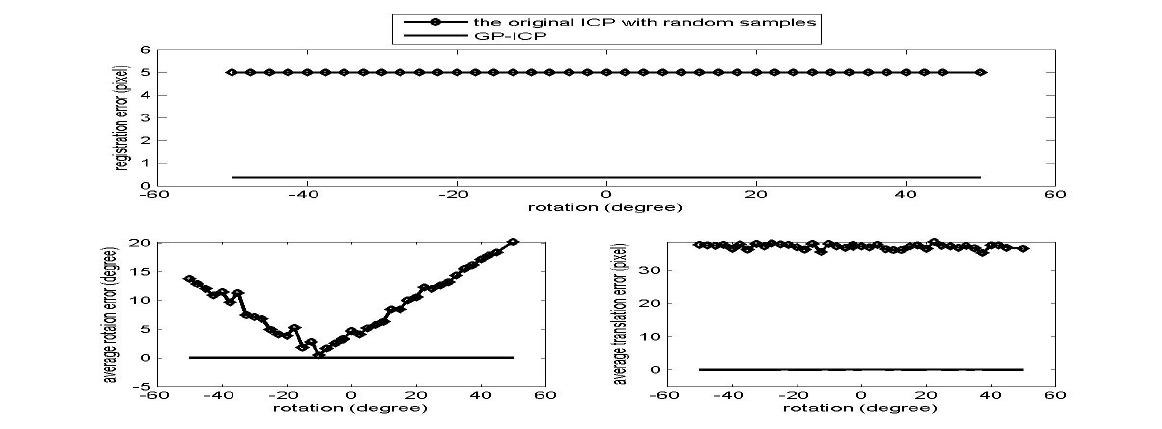
Figure 6. Convergence region test of the point clouds from the golf club with a translation, the translation 1, i.e. (-H/4, L/4,